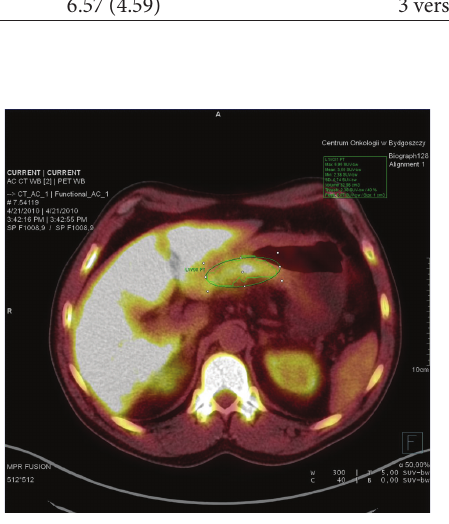
Figure 2: 18 FLT-PET in patient with mucinous adenocarcinoma. SUV max = 5.9 .